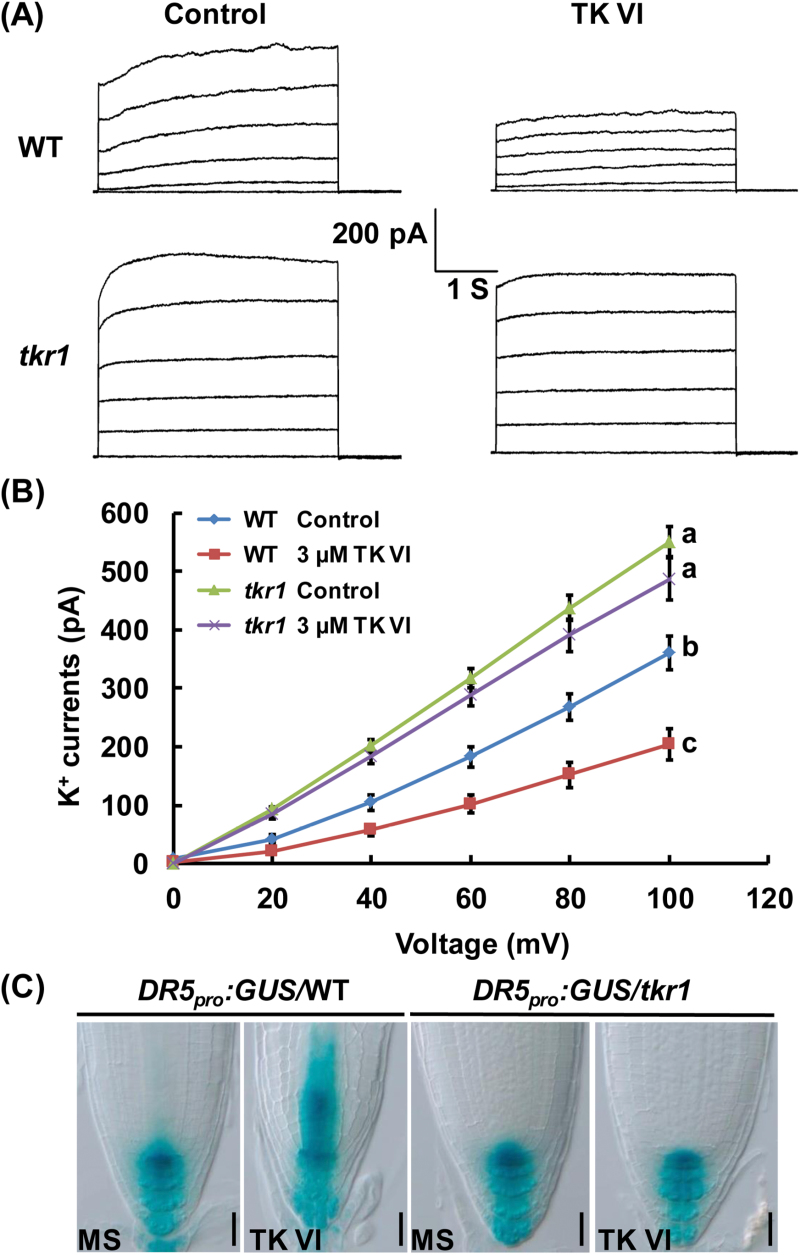
The effect of TK VI on outward K+ currents as analyzed by patch-clamp whole-cell recordings. (A) Patch-clamp whole-cell recordings of outward K+ current traces in wild-type (WT) and tkr1 root cell protoplasts without (Control) or with 3 μM TK VI. Time and current scales shown in the middle apply to all traces. (B) The current/voltage relationship of the whole-cell outward K+ currents as illustrated in (A). The number of protoplasts measured for the curves were 16 (for WT), 14 (for WT treated with 3 μM TK VI), 11 (for tkr1), and 11 (for tkr1 treated with 3 μM TK VI). Data shown are averages with the SD. Samples with different letters are significantly different; P<0.001. (C) Effect of TK VI on auxin distribution gradients in the WT and tkr1. DR5
pro
:GUS/WT and DR5
pro
:GUS/tkr1 seeds were germinated on medium without (MS) or with 3 μM TK VI for 5 DAG before GUS staining assays were performed. Scale bars=50 µm.